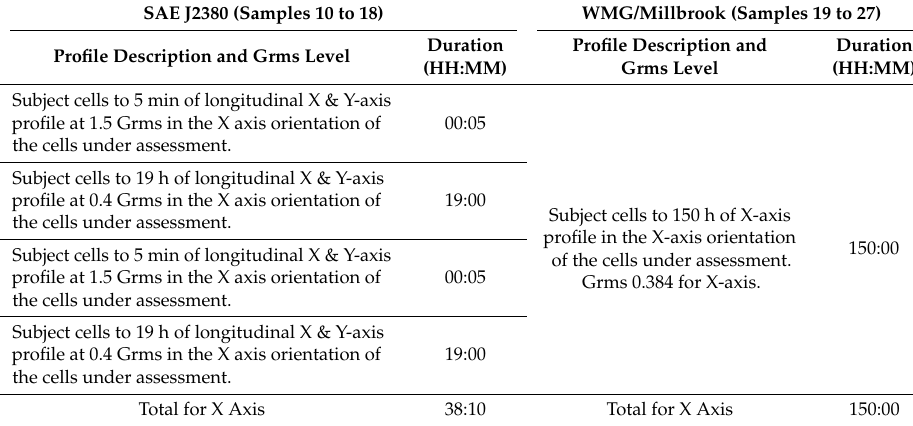
of the cells under assessment. Grms 0.384 for X-axis.